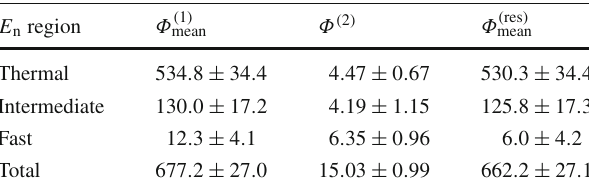
Table 8 Comparison of neutron fluence rates Φ ( 1 ) mean (reactor ON at constant mean level for time duration of 24h) and Φ ( 2 ) (reactor OFF), and their difference Φ (res) mean . All quantities are stated in units of [cm − 2 day − 1 ]. The uncertainties are stated as standard uncertainties (1 standard deviation). The definition of the E n regions is identical to the one used in Table 6